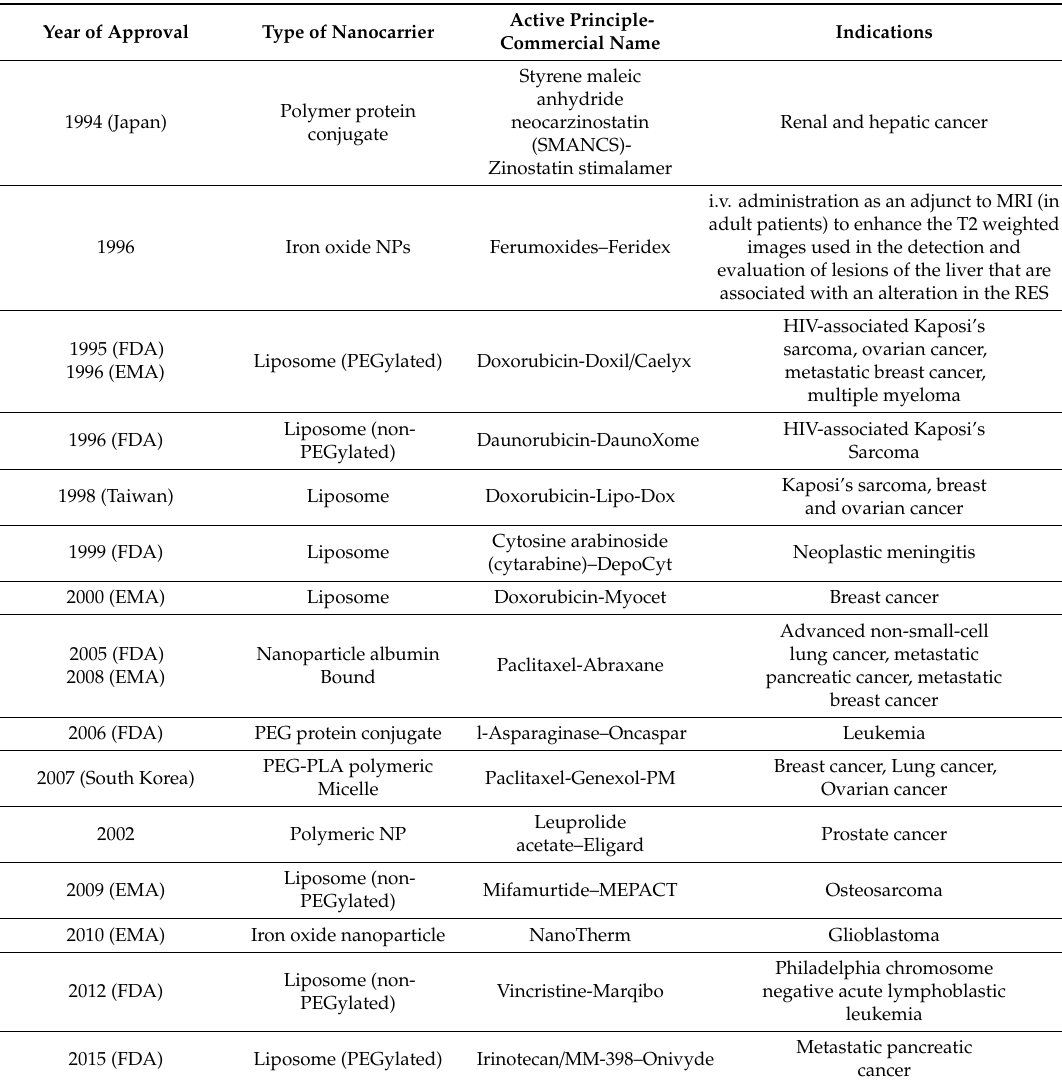
Table 2. Nanomedicines approved in